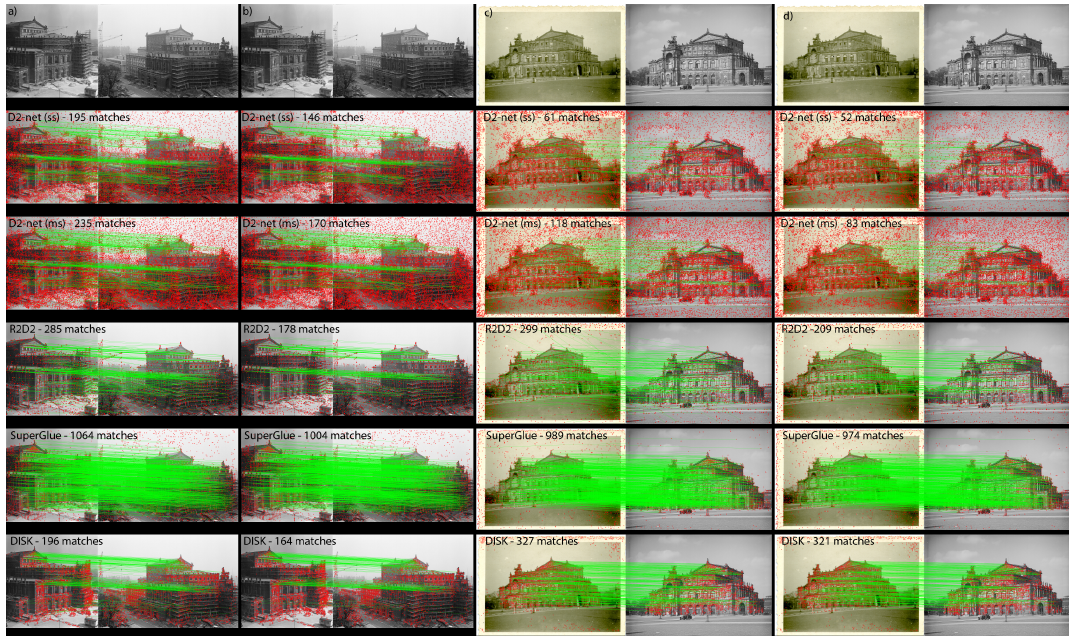
Figure A1. Example for feature matches on two different historical image pairs ( a – d ). ( a , c ) show initial keypoints and feature matches derived by different methods D2-net, R2D2, SuperGlue and DISK. ( b , d ) show resulting remaining feature points after geometric verification in